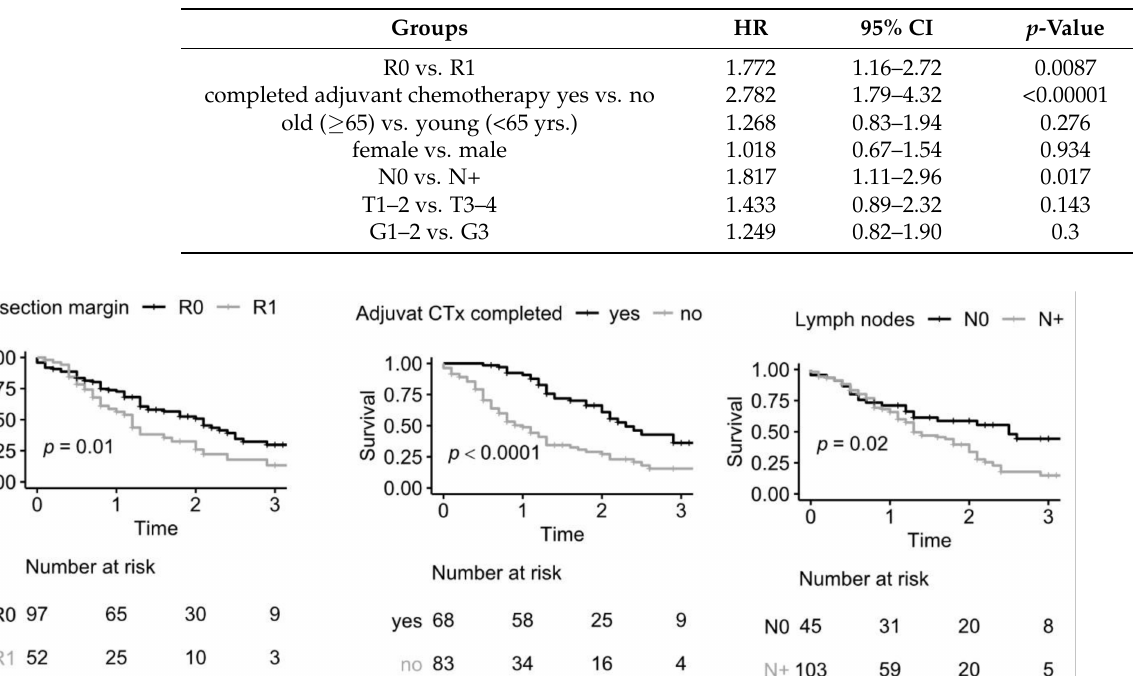
Table 2. Univariate Cox proportional hazard regression analysis of patient survival.